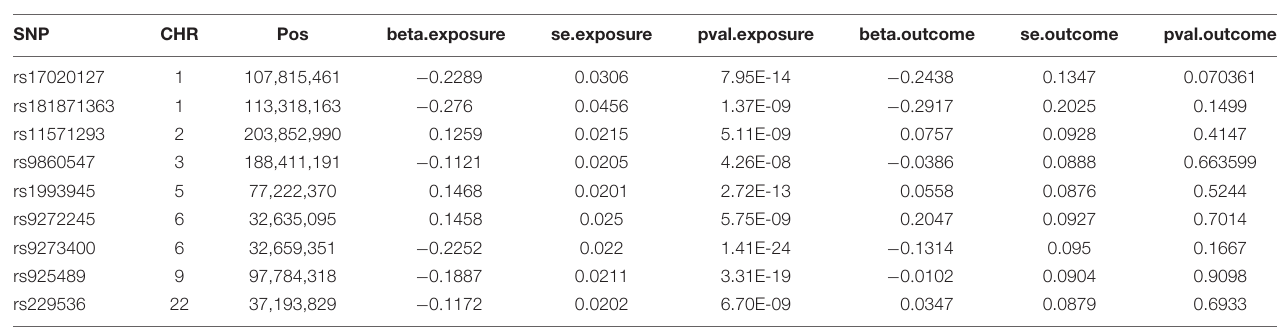
FIGURE 1 | A directed acyclic graph of MR model. IV assumption 1: IVs are strongly correlated with exposure. IV assumption 2: IVs are independent of outcomes (i.e., IVs can only affect outcomes through exposure). IV assumption 3: IVs are not related to confounding factors. MR, Mendelian randomization; IVs, instrumental variables. TABLE 1 | Associations of genetic variants between hypothyroidism and NAFLD.